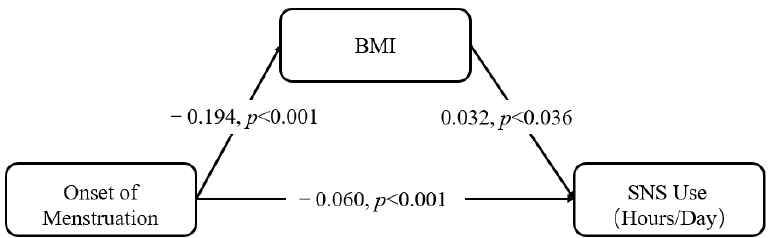
Figure 1. Mediation analysis of the effect of menstruation on SNS use through BMI. Note: Standard- ized coefficient and p -values are reported for each path.